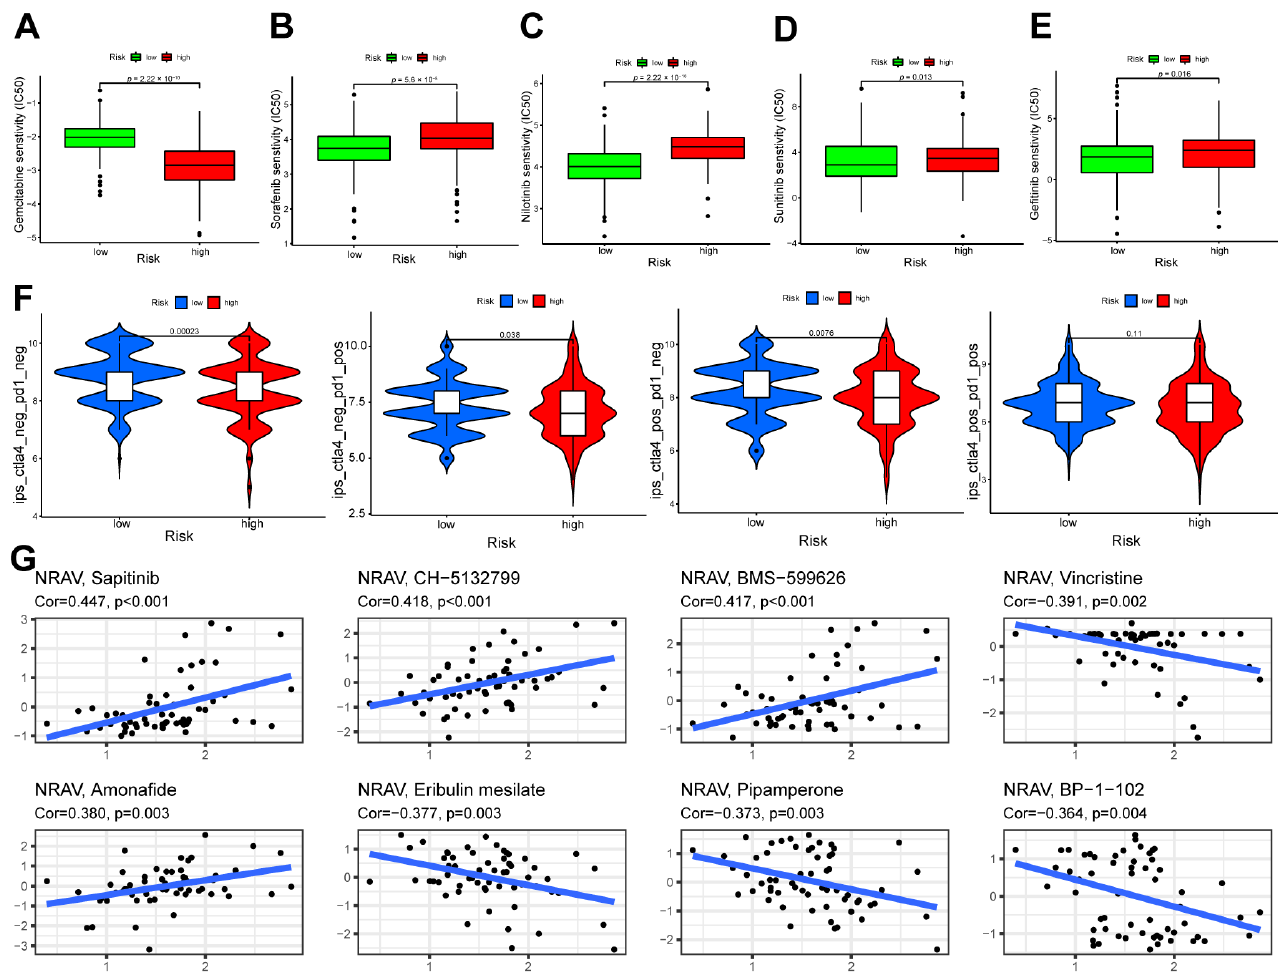
Figure 6. Drug sensitivity analysis and small molecule drug prediction. ( A – E ) IC50 sensitivity analyses of gemcitabine, sorafenib, nilotinib, sunitinib, and gefitinib between the high- and low-risk groups. ( F ) The differences of IPS-CTLA( − )-PD1( − ), IPS-CTLA( − )-PD1(+), IPS-CTLA(+)-PD1( − ), and IPS-CTLA(+)-PD1(+) between the high- and low-risk groups. ( G ) The scatter plot show sensitivities of small molecule drugs related with the expression of NRAV. (The top eight drugs are displayed).